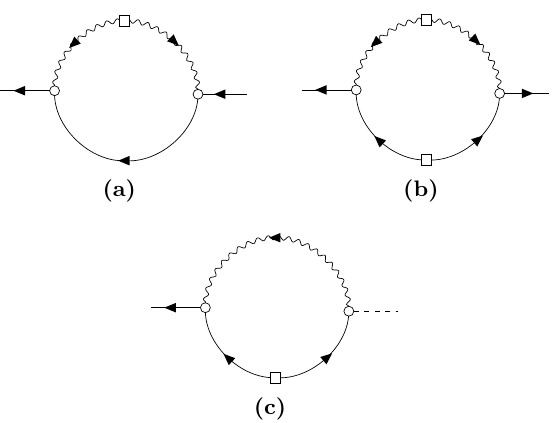
Figure 4. Contributions to the density response and density correlation that arise from the coupling to the momentum density. Figure (a) and (b) show the retarded function and correlation function at leading order in the advective couplings. Figure (c) shows the vertex function for the composite operator X that appears in the FD